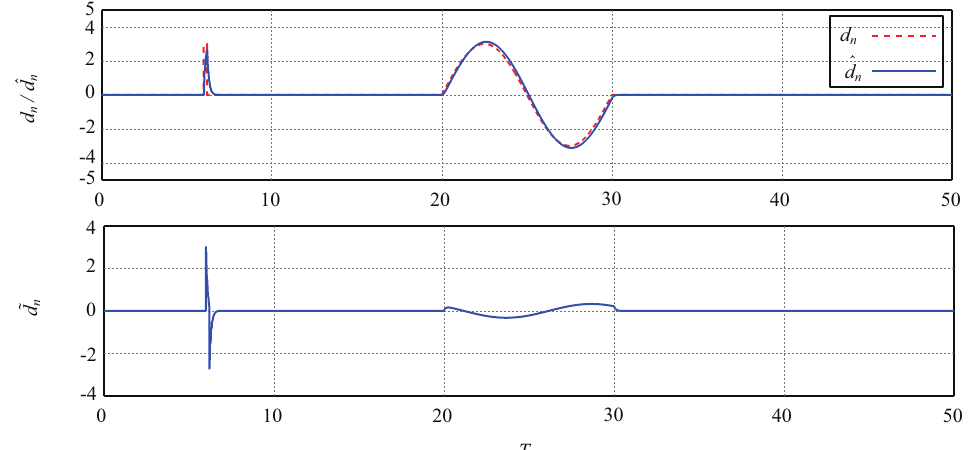
Figure 10. Estimation performance of LESO to the disturbance in Case